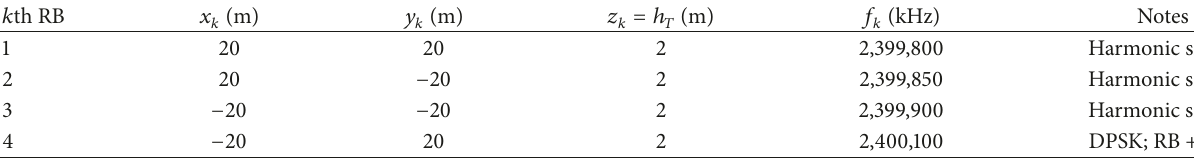
Table 1: Location coordinates of RBs and frequencies of signals emitted by them.